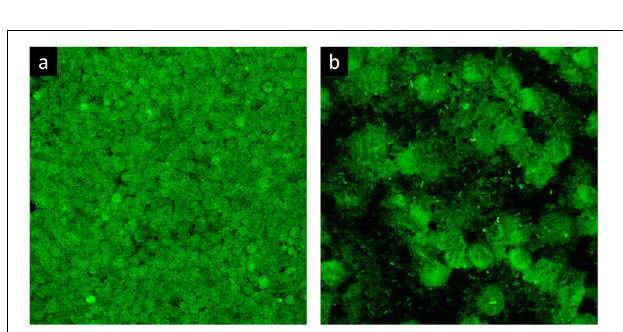
FIGURE 3 | α -Fibrin antibody directly detects fibrin incorporated into the matrix of Staphylococcus aureus 4 biofilm-like aggregates in infected synovial fluid clinical sample. Left panel, SYTO 9 for cellular biomass (green); right panel, α -fibrin antibody (gray).